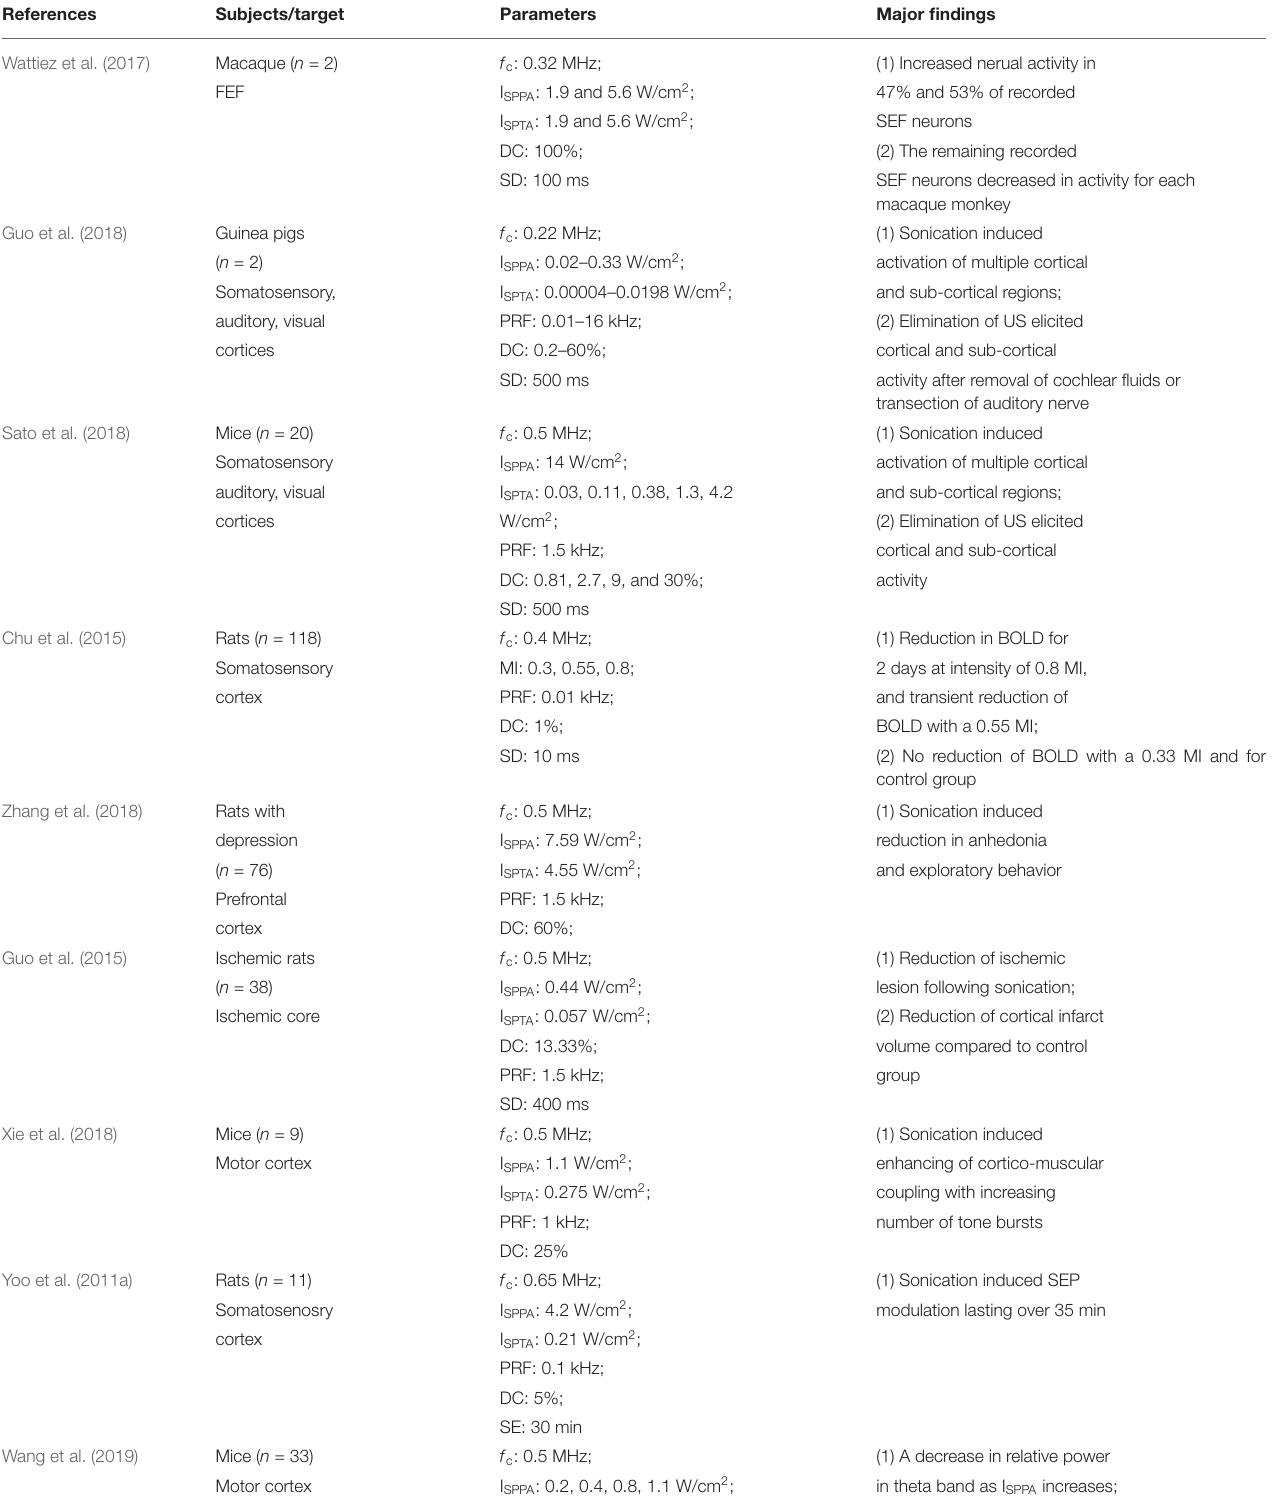
TABLE 4 | Other findings for animals and